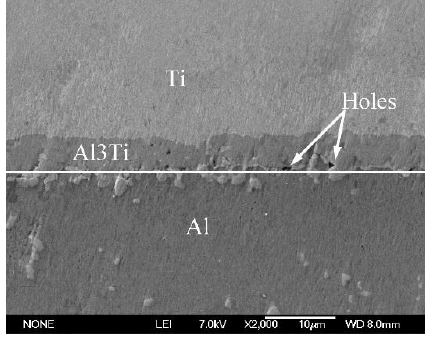
Figure 17. An SEM micrograph of the Al/Ti interface after heating for 5 h.